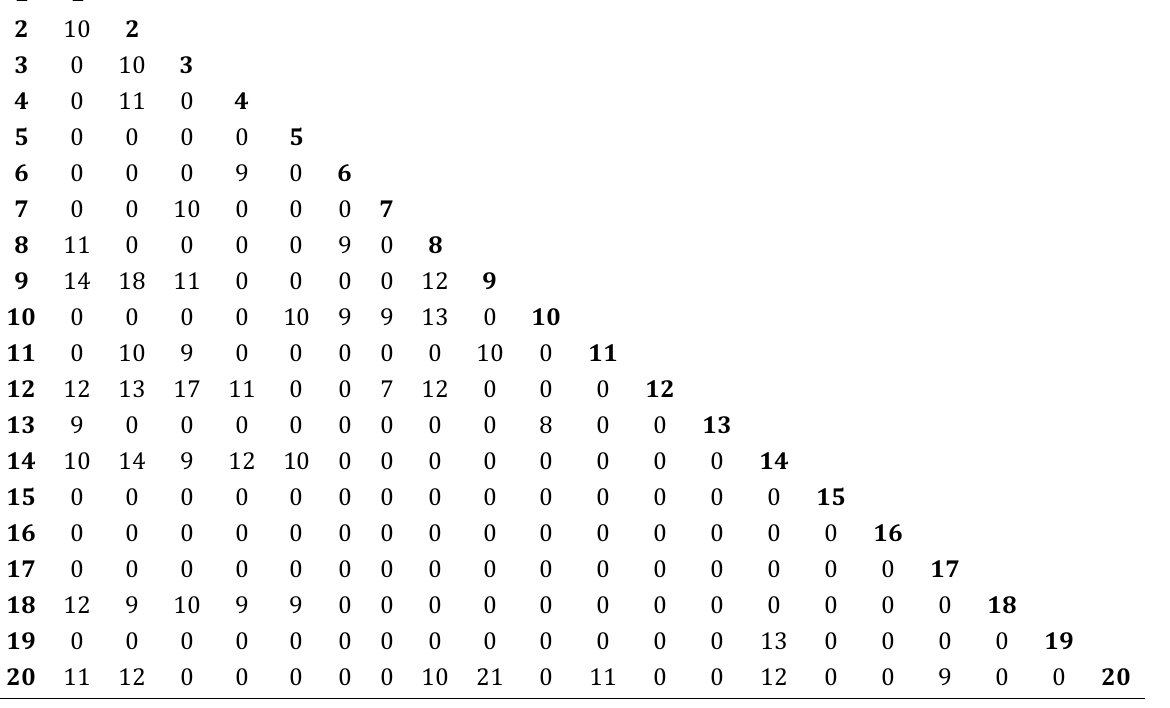
Table 2. Matrix of transportation percentage between facilities.